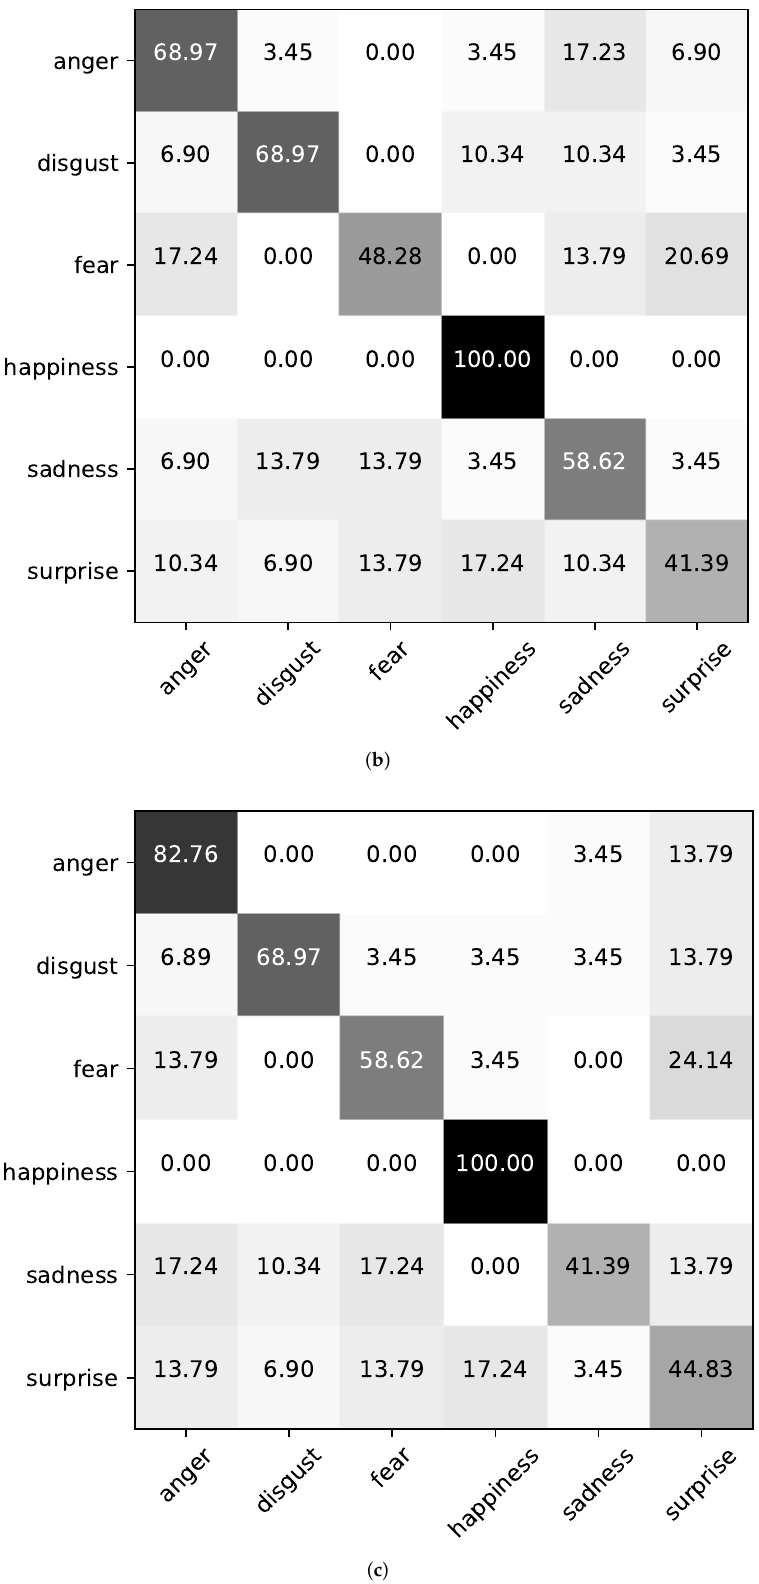
Figure 4. The confusion matrices of different methods on the RAVDESS dataset. ( a ) Baseline (A+V), ( b ) Ours (wo corr), ( c )